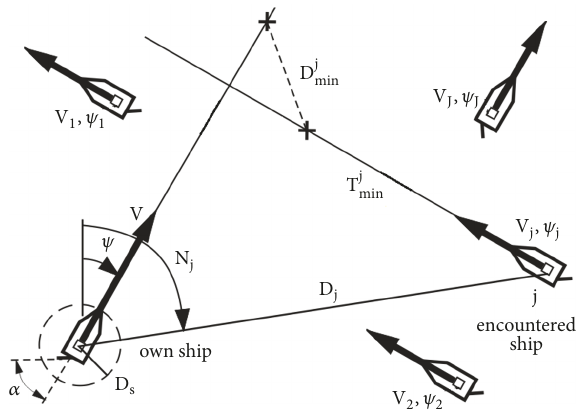
Figure 2: Possible trajectories of the own ship in case of passing the encountered